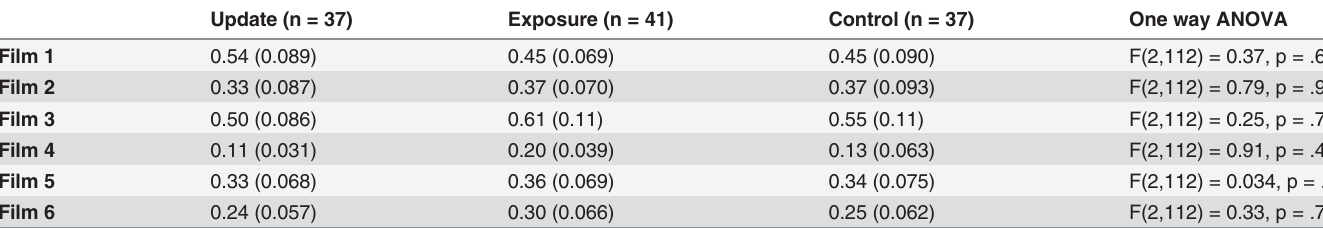
Table 3. SCR during acquisition films (means and bootstrapped standard errors).